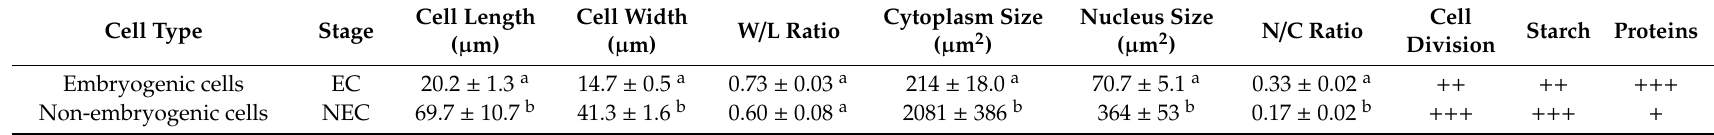
Table 5. Characteristics of the mainly represented cell populations in embryogenic (EC) and non-embryogenic calli (NEC).